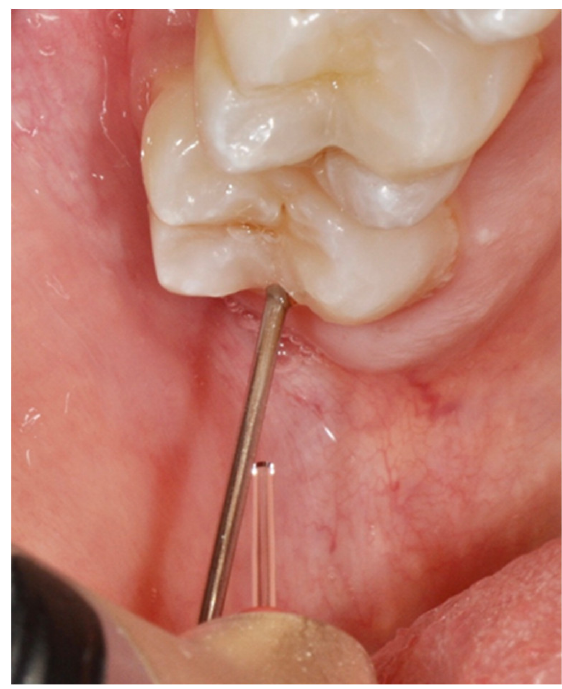
Figure 4. Rabbit technique: irradiation from the occlusal side of the tooth.